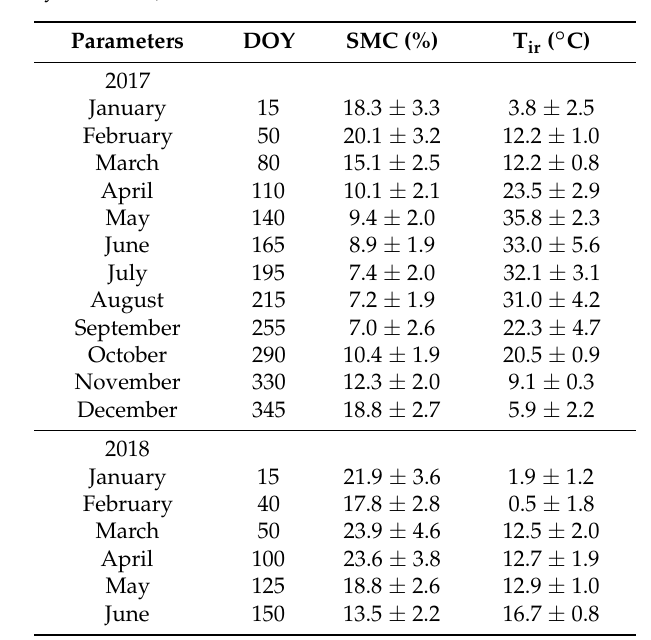
Table 1. Descriptive statistics (mean ± standard deviation) of soil moisture content (SMC) and pasture surface temperature (T ir ) measured at the 12 sampling points of the studied field, for each